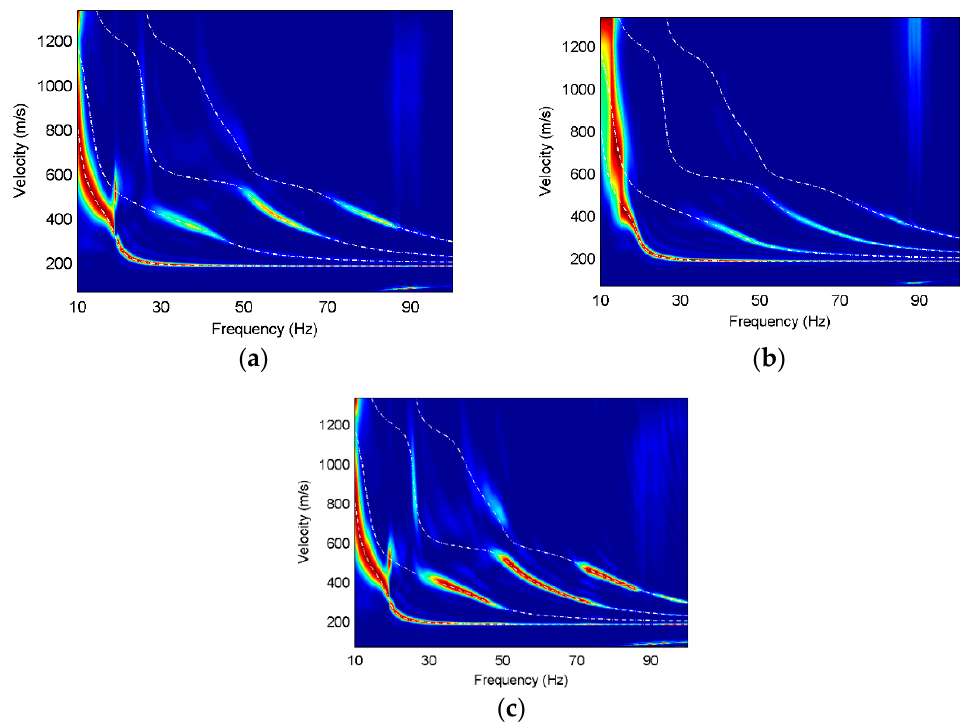
Figure 5. Dispersion images for Model 3, where the white dashed lines are the theoretical dispersion curves and the red color represents the maximum energy. ( a ) X component of Model 3; ( b ) Z component of Model 3; ( c ) R y component of Model 3.